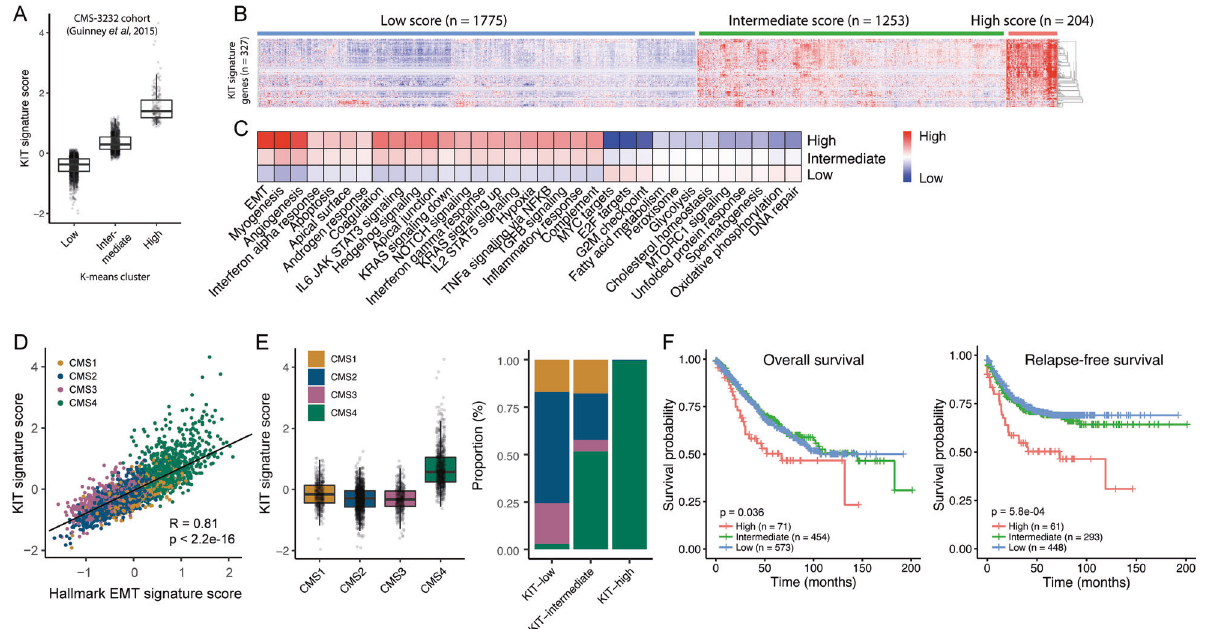
Fig. 1 KIT co-expressed genes identify a subgroup of metastasis-prone tumors and are strongly correlated with CMS4. A Boxplot showing the “ KIT-co expressed signature ” score for KIT-low, KIT-intermediate, and KIT-high groups in the large transcriptome cohort ( n patients = 3232) [1]. The groups are clustered by using the k-means algorithm ( n = 3). B Heat map showing the expression levels of 327 genes in the “ KIT-co expressed signature ” for the three groups. C Gene set enrichment analyses of hallmark signatures for KIT-low, KIT-intermediate, KIT-high annotated tumors. D Scatter plot showing the correlation of “ KIT-co expressed signature ” expression values in relation to the hallmark Epithelial-Mesenchymal-Transition signature. E Boxplot showing “ KIT-co expressed signature ” score per CMS-type and stacked bar plot showing the CMS distribution in KIT-annotated subgroups. F Kaplan – Meier curves showing overall- (left) and relapse-free (right) survival in tumor subgroups de fi ned by the “ KIT-co expressed signature ” in the CMS3232 cohort [1]. A two-sided log-rank test was applied to assess the signi fi cance of the survival differences between the two